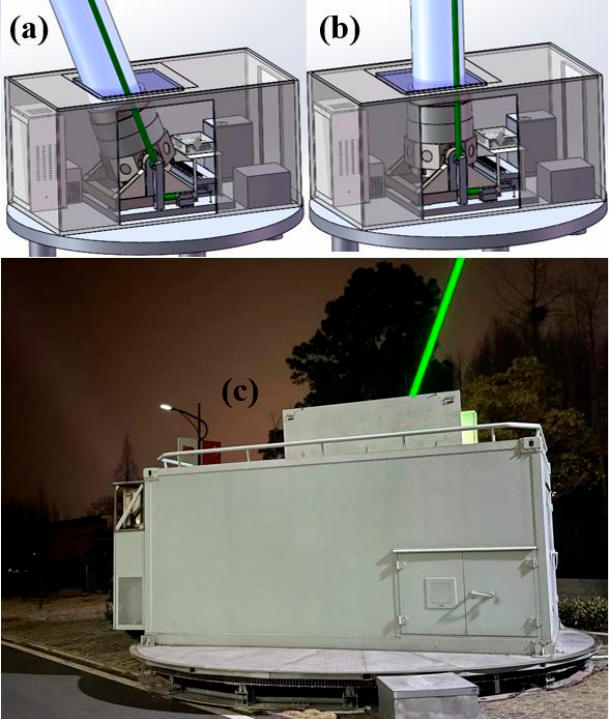
Figure 1. Active Rotating Tropospheric Stratospheric Doppler Wind Lidar. ( a ) Tilt detection mode. ( b ) Vertical detection mode. ( c ) Schematic diagram of detection work.